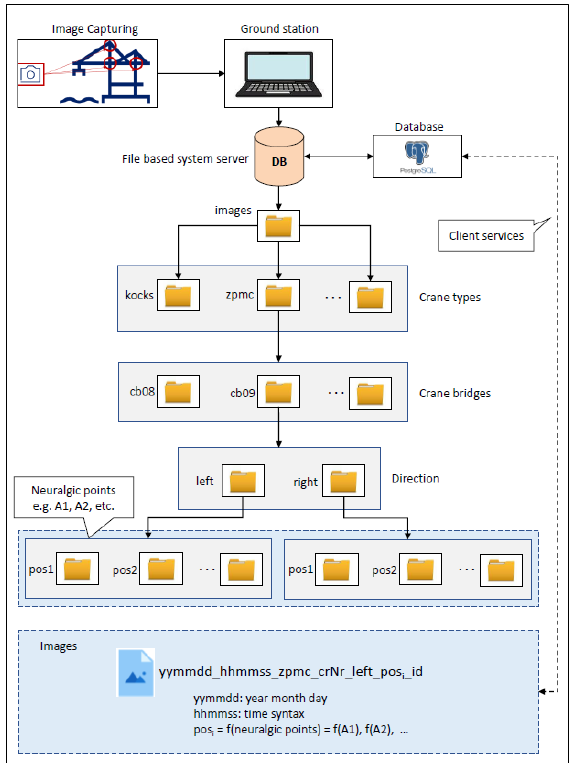
Figure 3 . Concept of the data structure and image naming